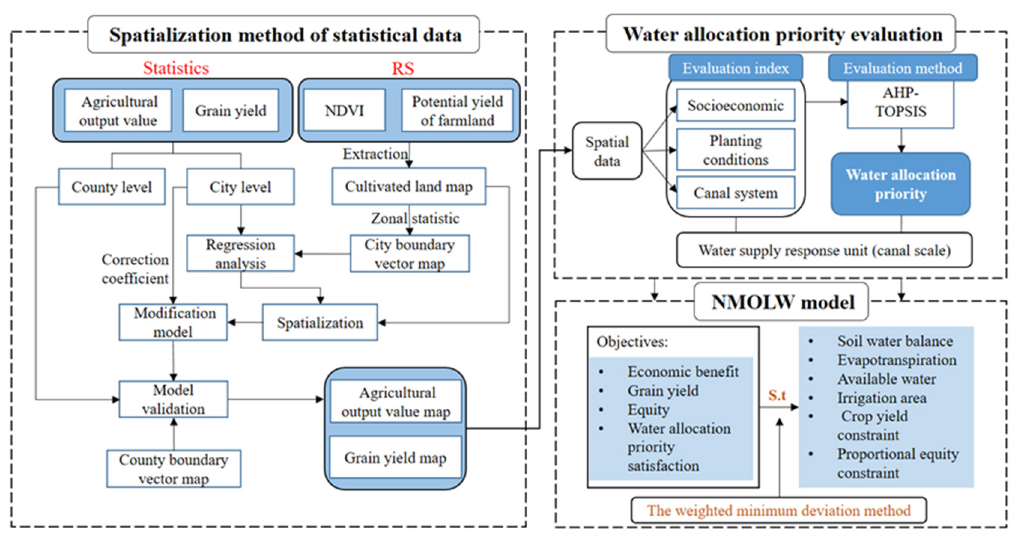
Figure 1. Study framework.